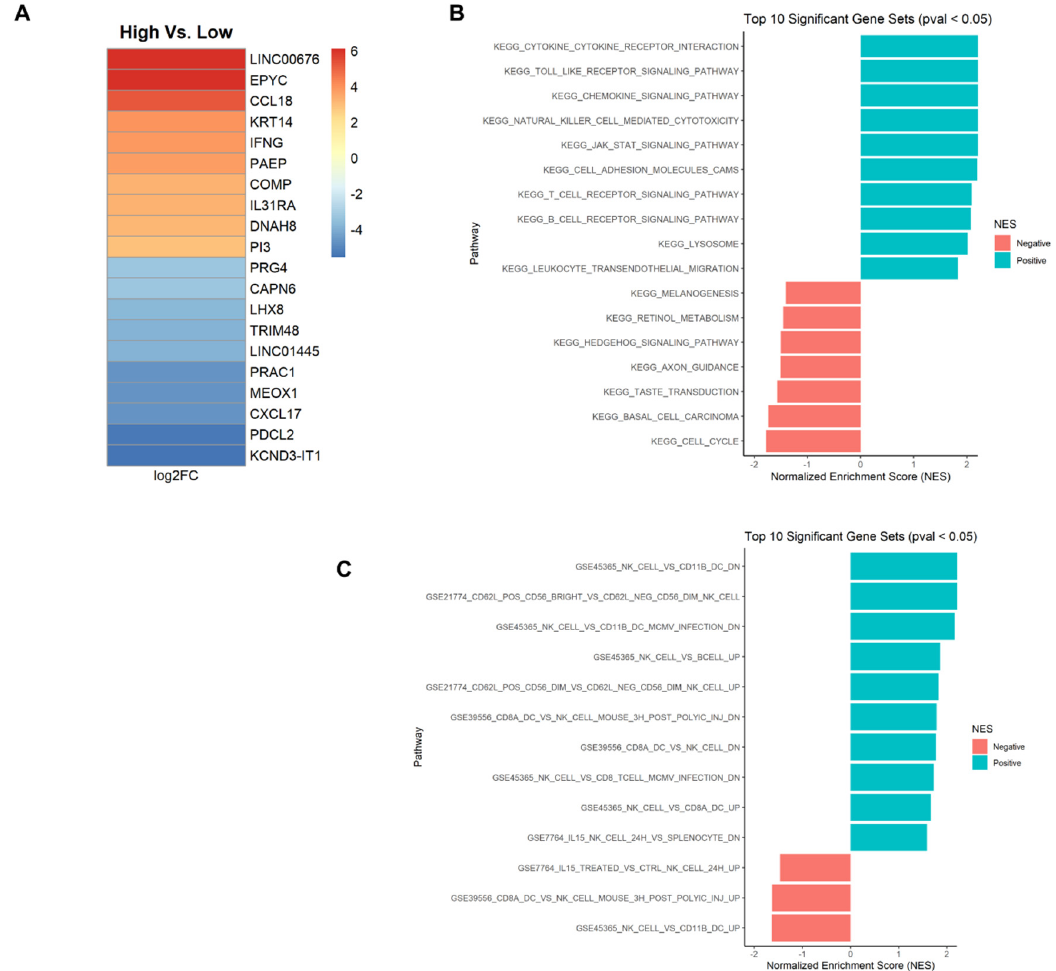
Figure 6. Bioinformatics analysis of GBM patient data (TCGA) stratified for HAVCR2 (TIM-3) expression and correlation to NK cell function. ( A ) Heatmap of top 10 up- and down-regulated DE genes in HAVCR2 + GBM patients show upregulated IFNG ; ( B ) GSEA analysis with KEGG collection from the Molecular Signatures Database (MSigDB) shows upregulation of NK cytotoxicity and JAK/STAT signaling pathways in HAVCR2 + samples; ( C ) NK cell-related gene sets from KEGG, GO.Biological Processes and Immunologic collections show enrichment in CD62L + CD56 dim NK cell presence on TIM-3 + GBM.